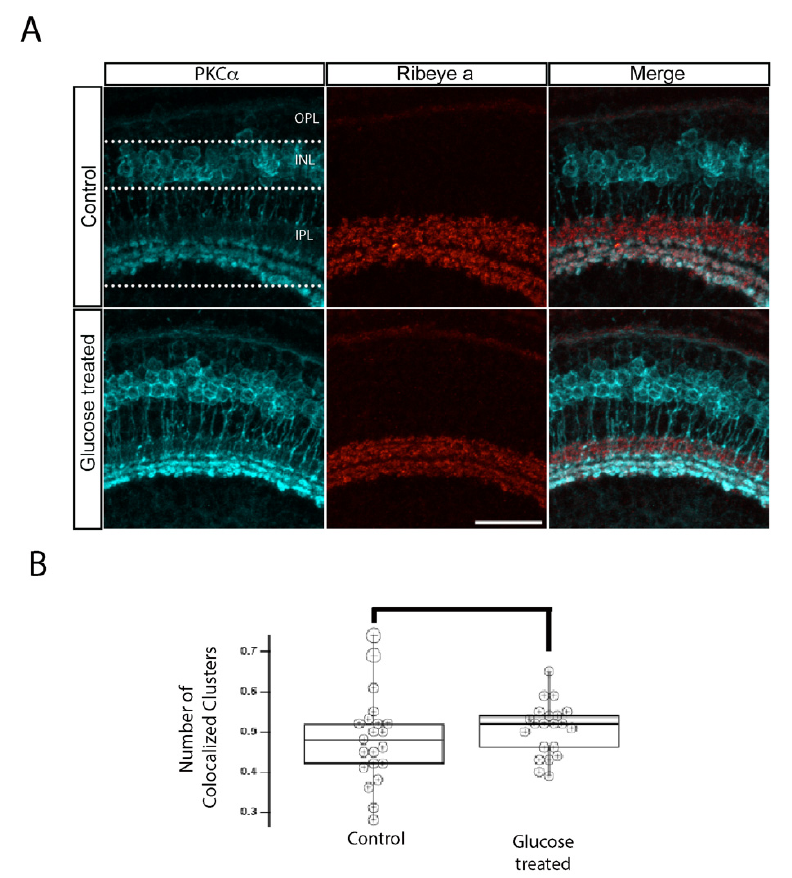
Figure 6. IPL ribbon synapses of bipolar cells are preserved in hyperglycemic larvae. ( A ) Transverse retinal sections from 5 dpf control ( top ) and hyperglycemic ( bottom ) larvae were double immunostained with fluorescently labeled antibodies specific for the rod bipolar cell marker PKC α (cyan; left panels ) or ribeye a (red; middle panels ); also shown is the overlay of PKC α and ribeye a labeling (merge; right panels ). Maximal intensity projections are shown, and the relative positions of the OPL, INL, and IPL are indicated. Scale bar, 5 μ m. The expression pattern of PKC α -labeled rod bipolar cell neurons, synaptic ribbons in the IPL layer, and the number of ribbon synapses in rod bipolar cells are normal in 5 dpf hyperglycemic larvae. ( B ) Quantitative analyses of IHC for colocalization of PKC α and ribeye a are indicated by box-and-whisker plots. Boxes indicate median values, and whiskers indicate 5th–95th percentile values of pooled data from 56 larvae. The data represent the total ribeye a labeling in PKC α -labeled terminals ( p > 0.05). Abbreviations used: Dpf, days post-fertilization; PKC α , protein kinase C alpha; SEM, standard error of the